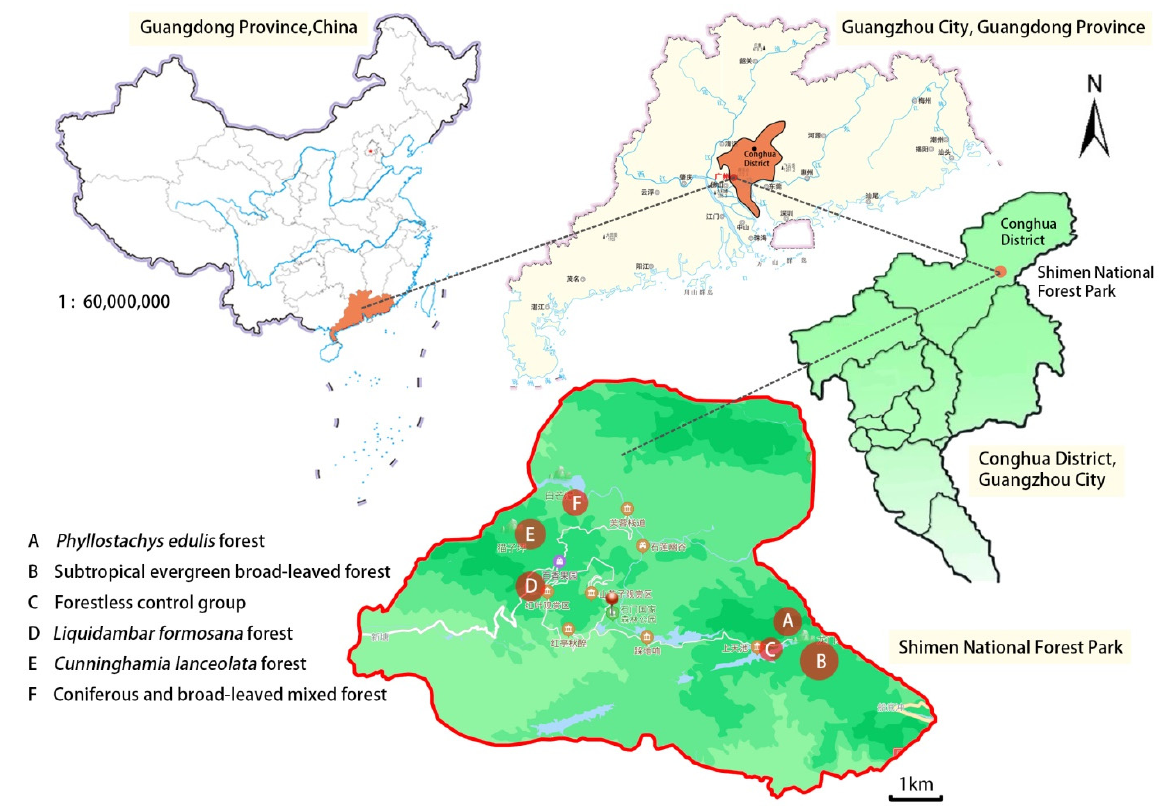
Figure 1. Location of the Shimen National Forest Park.